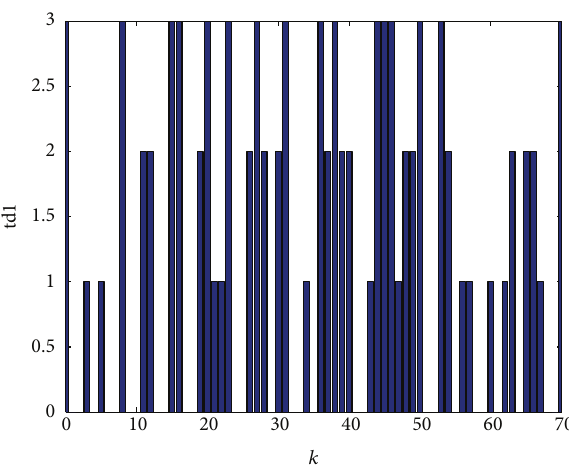
Figure 9: Bounded arbitrary time delays (Example 1).